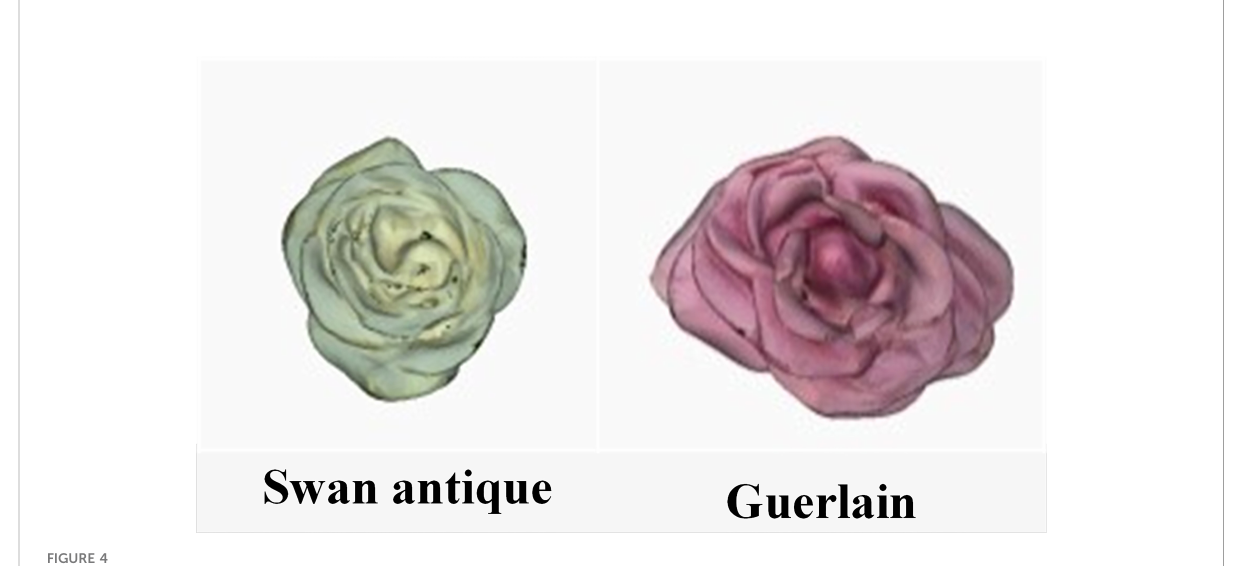
FIGURE 4 Input 3D models of Chinese